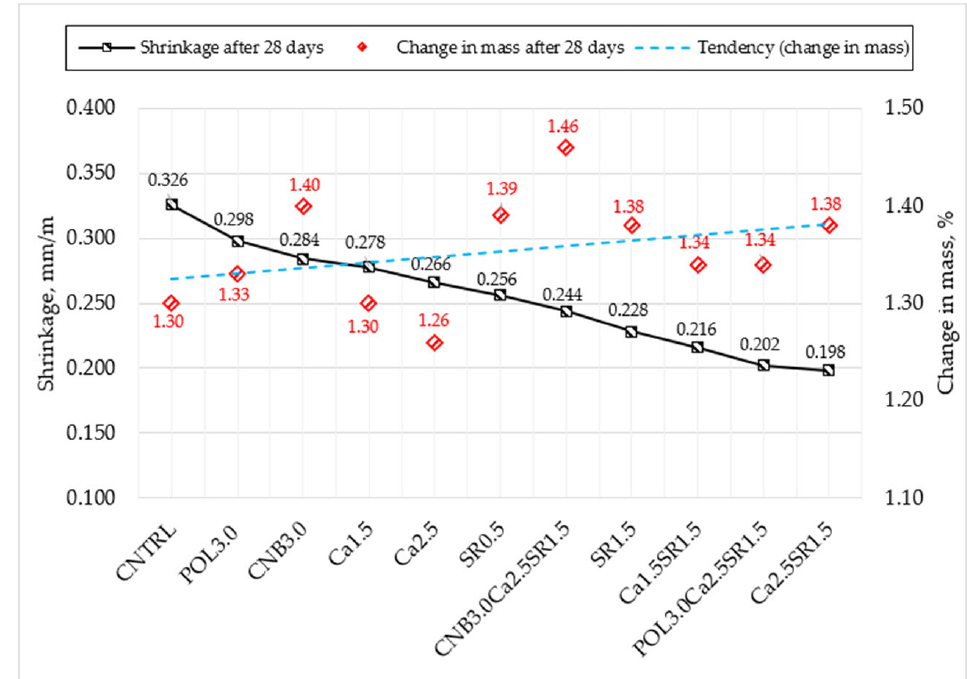
Figure 11. Relationship between shrinkage and change in mass after 28 days.